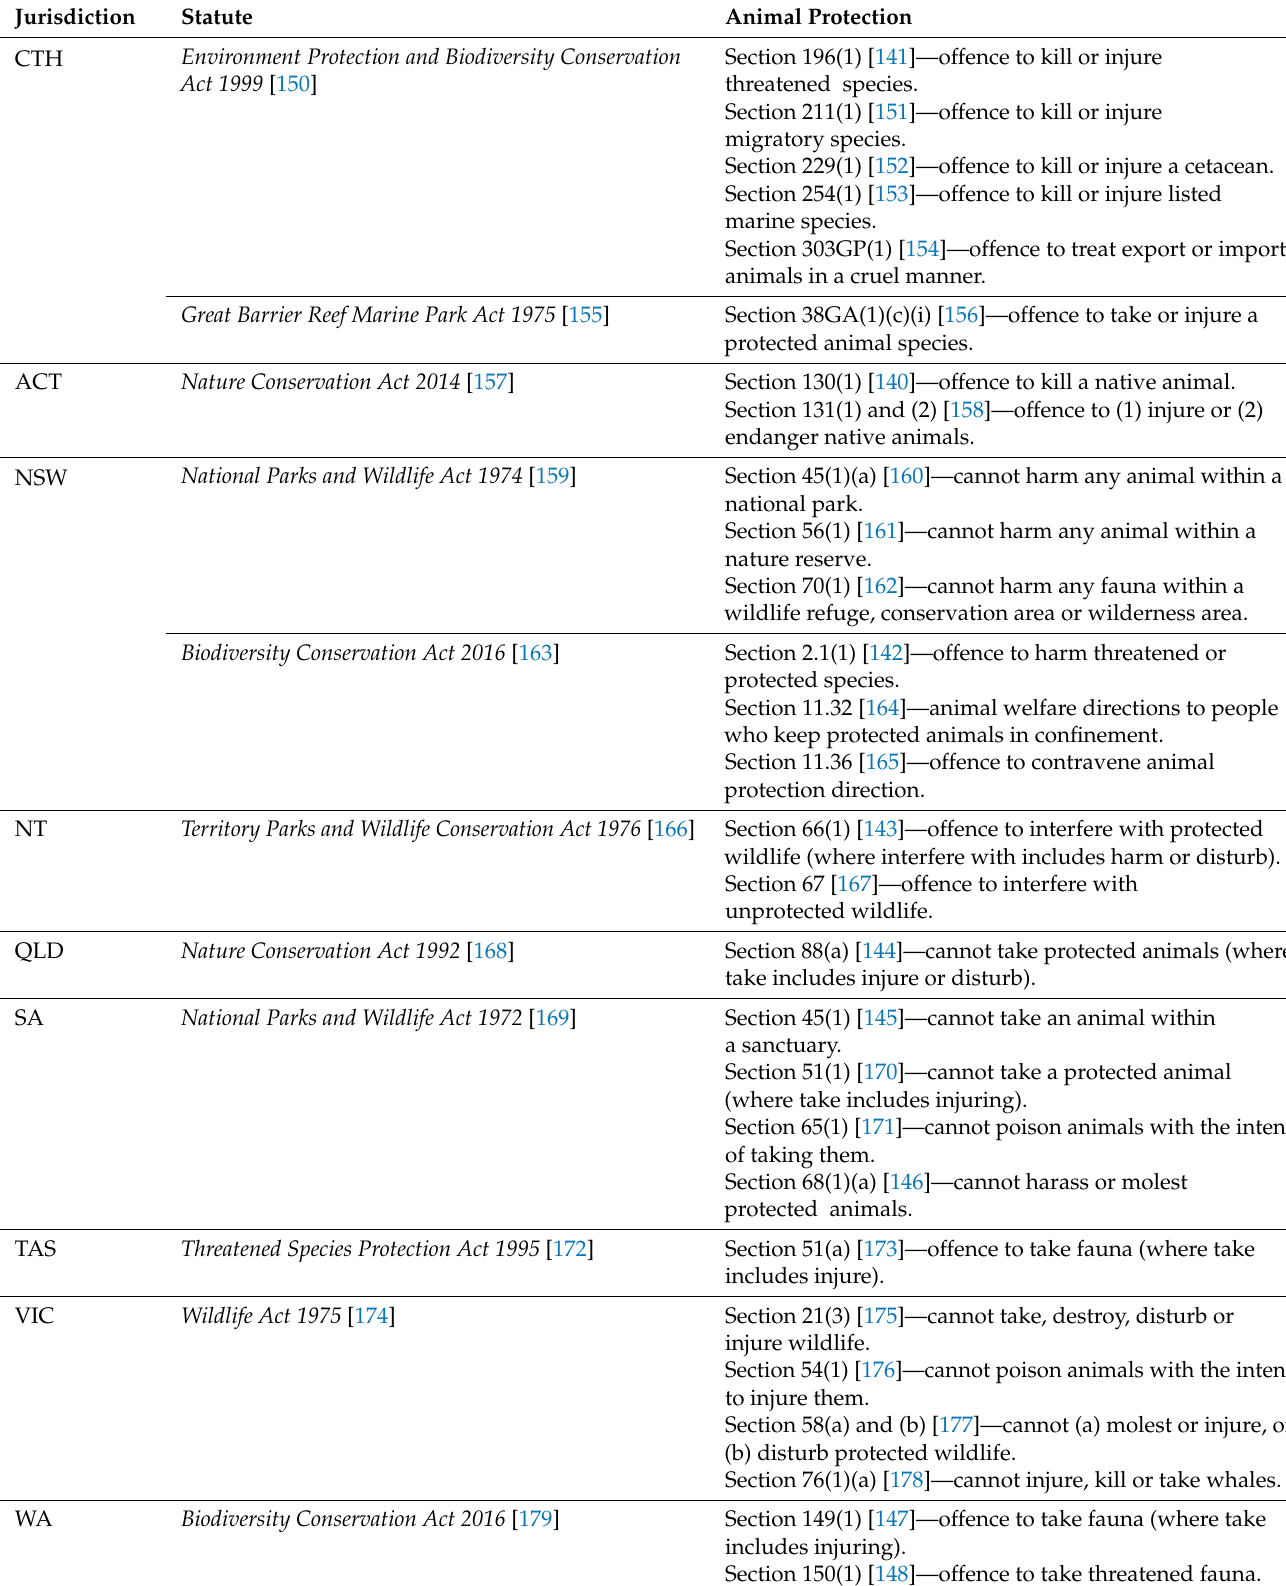
Table 11. Each wildlife protection statute and the corresponding animal protection provisions per each Australian state and territory. Statutes only award protection to native wildlife species in Australia. Offences have been